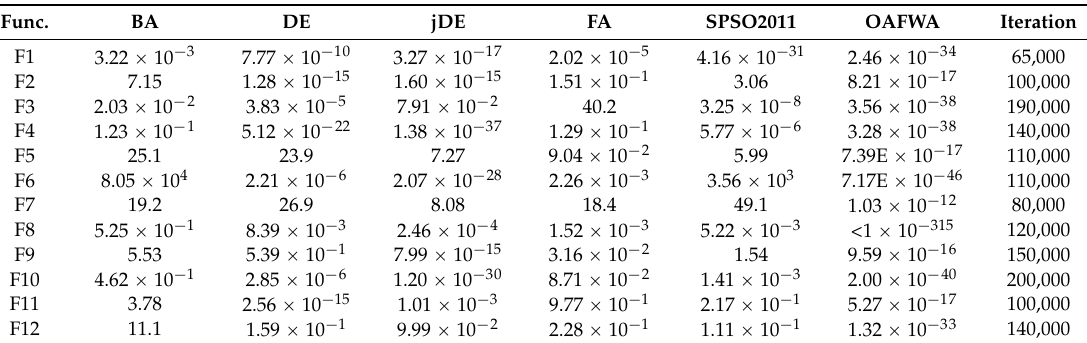
Table 10. Mean errors for the six algorithms when popSize =